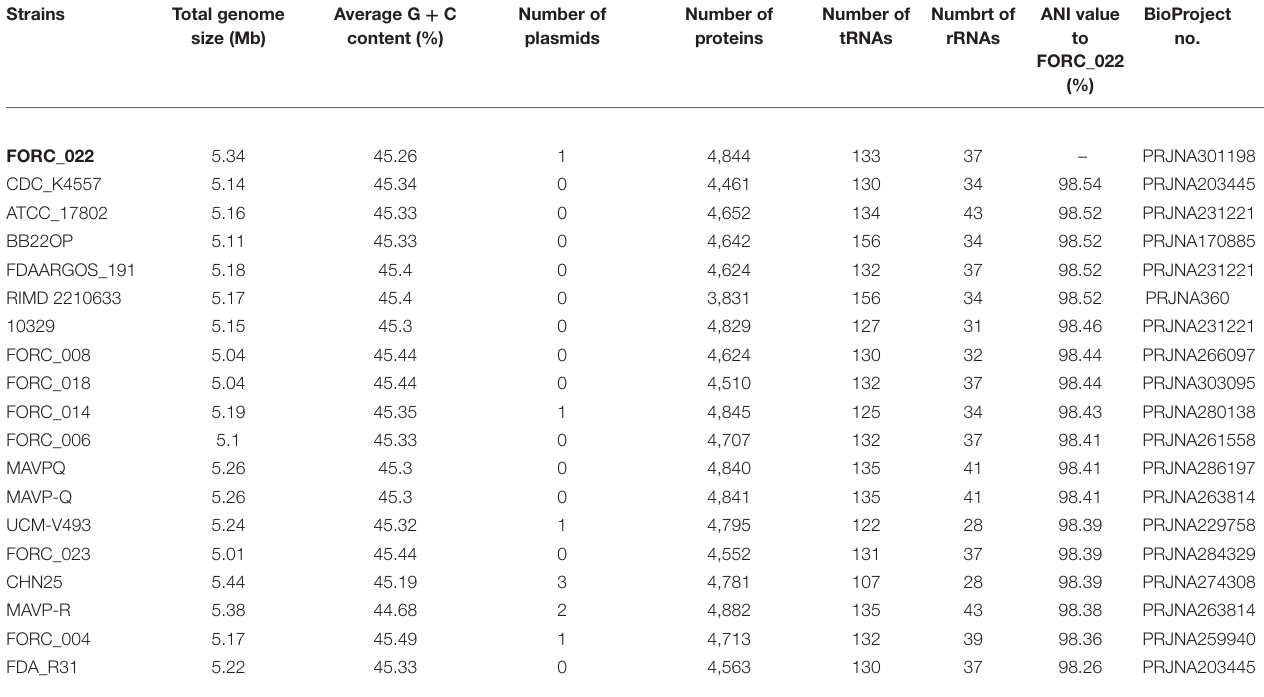
TABLE 1 | Genome features of completely sequenced Vibrio parahaemolyticus strains and average nucleotide identity (ANI) values to